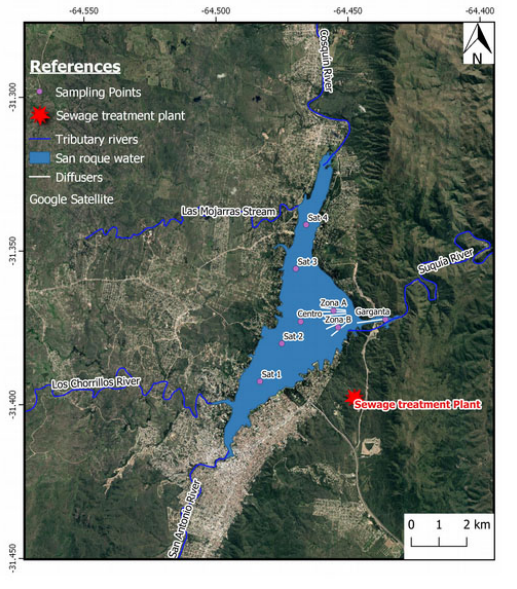
Figure 1. Map of San Roque reservoir and its monitoring stations and tributary rivers